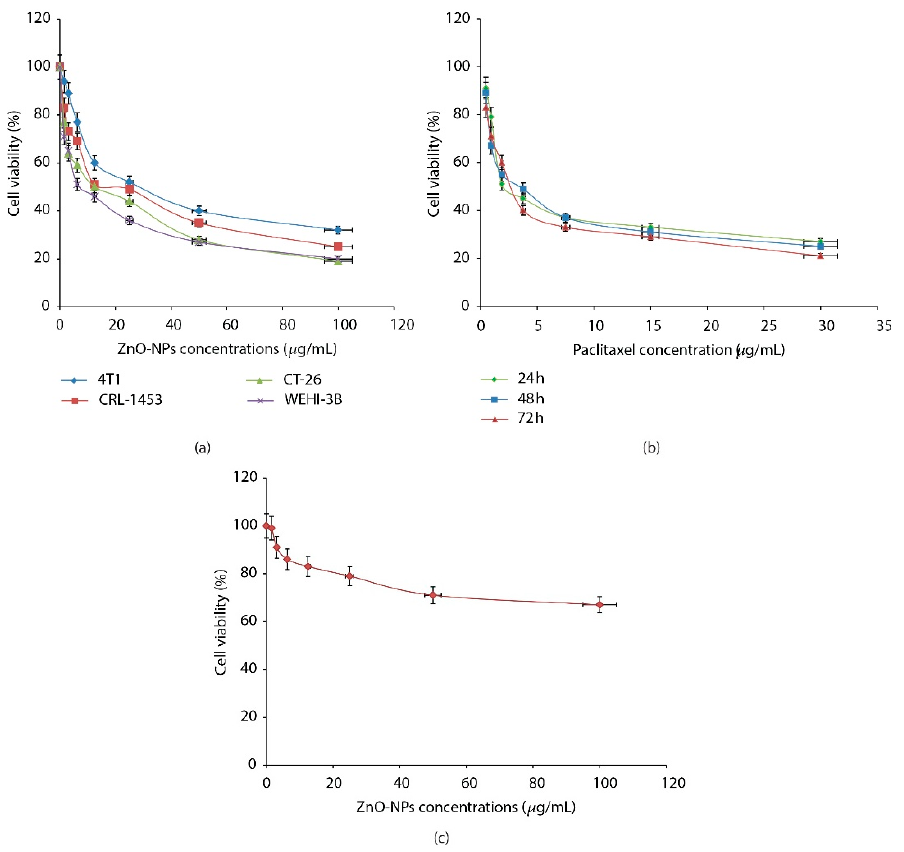
Figure 4. Cell viability evaluation of various cancer cells against ZnO NPs ( a ), cell viability evaluation of WEHI-3B cells against PTX ( b ), cell viability evaluation of normal mouse fibroblast cell against ZnO NPs ( c ). Reproduced with permission from [66] (copyright 2015, Hindawi).